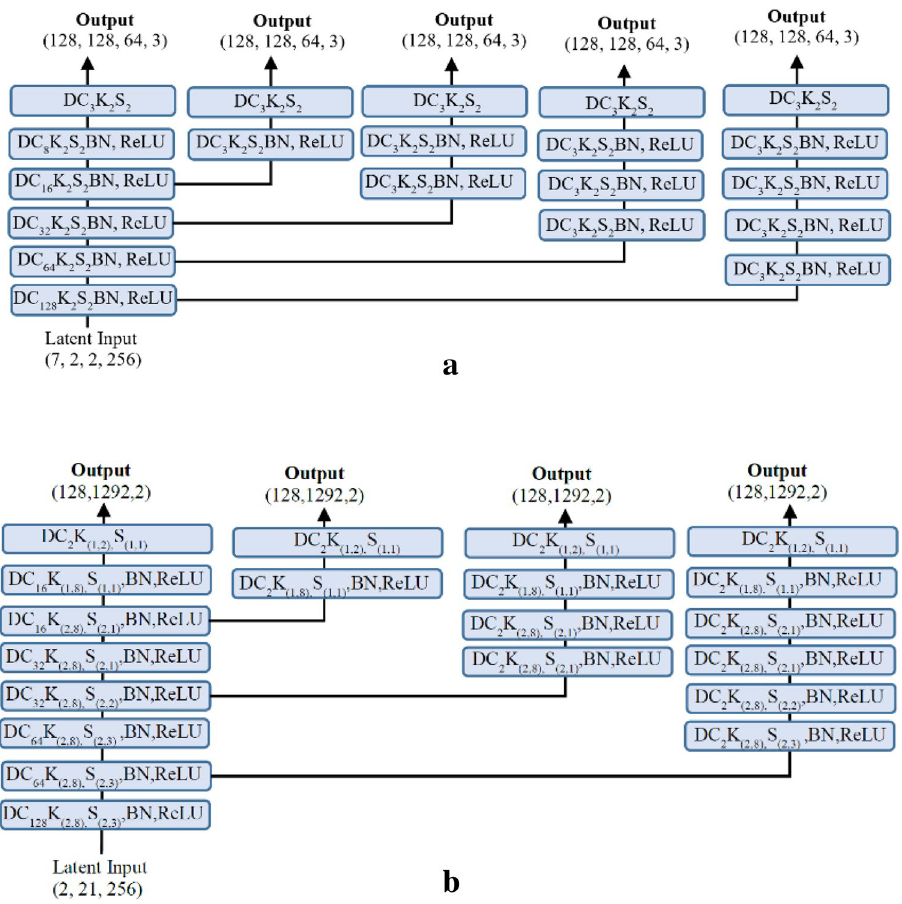
Figure 7. ( a ) The 3D video decoder network with multi-stage loss. ( b ) The 2D audio decoder network with multi-stage